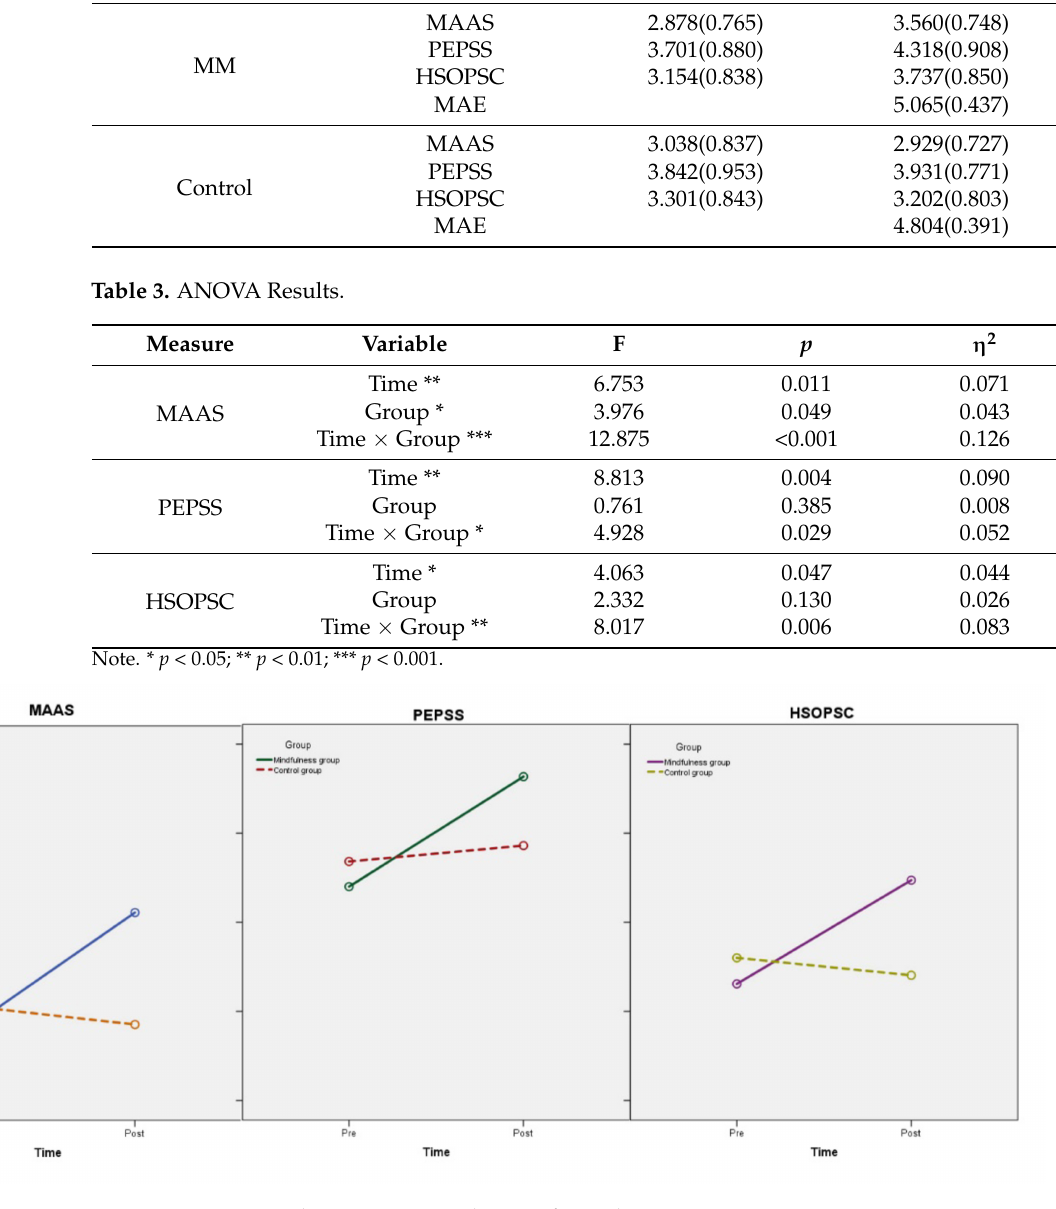
Figure 2. Interaction between time and group for each